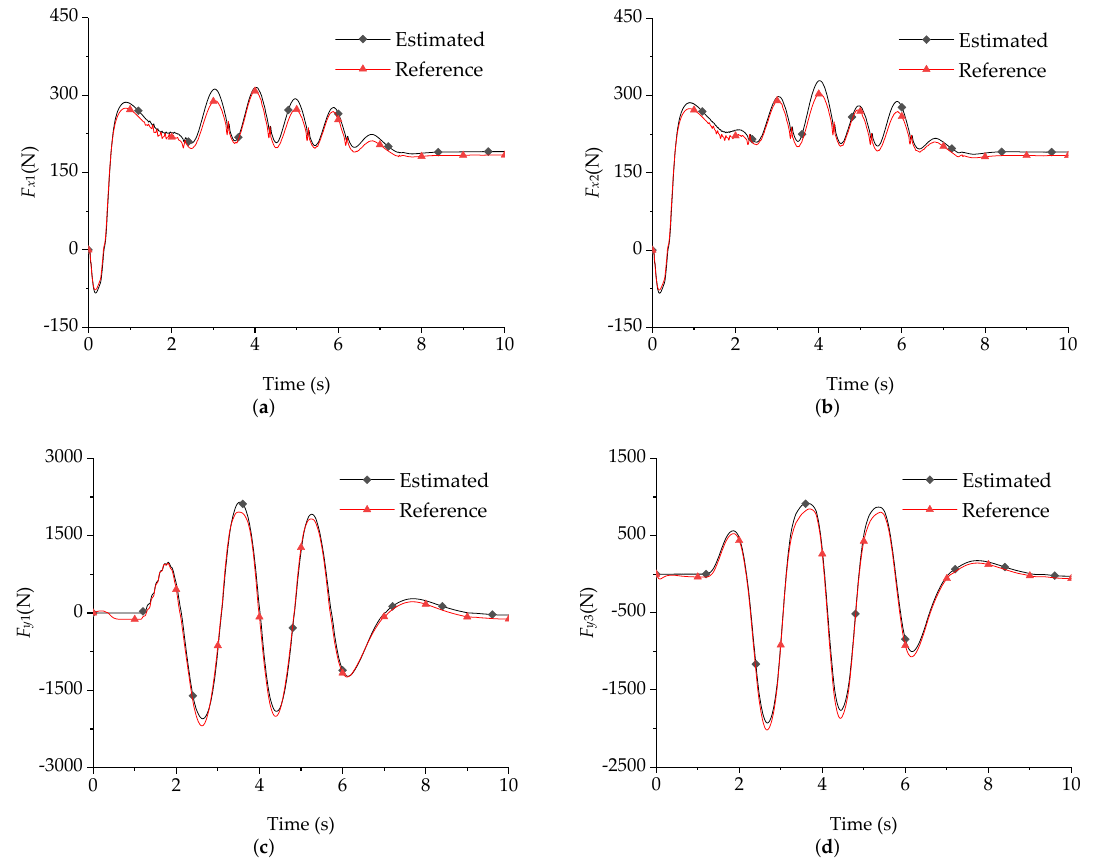
Figure 7. Estimation results of tire forces. ( a ) Longitudinal force of left front tire; ( b ) Longitudinal force of right front tire; ( c ) Lateral force of left front tire; ( d ) Lateral force of left rear